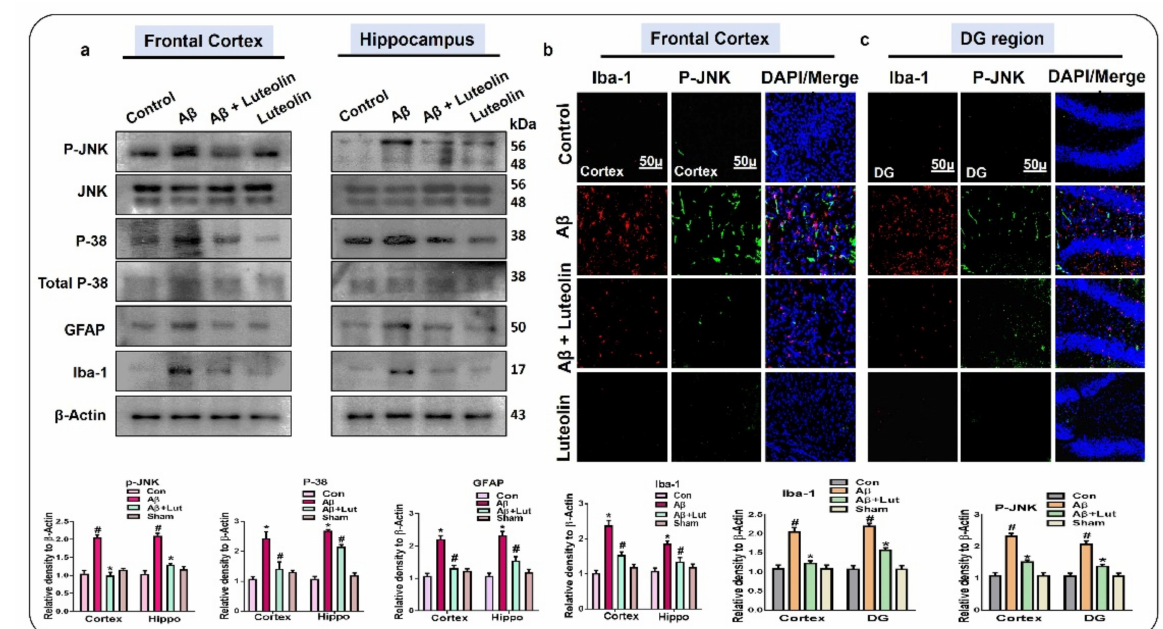
Figure 2. Luteolin reversed the activation of stress kinases and glial cells-mediated neuroinflammation, i.e., p-JNK/p- 38/GFAP/Iba-1 in A β 1 – 42 -treated mice brains. ( a ) Western blots results of p-JNK/p-38/GFAP/Iba-1 in the frontal cor- tex and hippocampus of the experimental mice brains. β -Actin was used as a loading control. ( b , c ) Immunofluores- cent co-localization of p-JNK/Iba-1 in the frontal cortex and DG region of the hippocampus in the experimental mice. Magnifications10 × . Scale bar 50 µ m. confocal image analysis was done using ImageJ software. Values are the means ± SEM from three independent experiments. For the statistical analysis, Graph Pad Prism 5 was used, and one-way ANOVA and posthoc multiple comparison tests were employed. * p < 0.05 represents control versus A β -treated mice, # p < 0.05 represents A β + Luteolin-treated